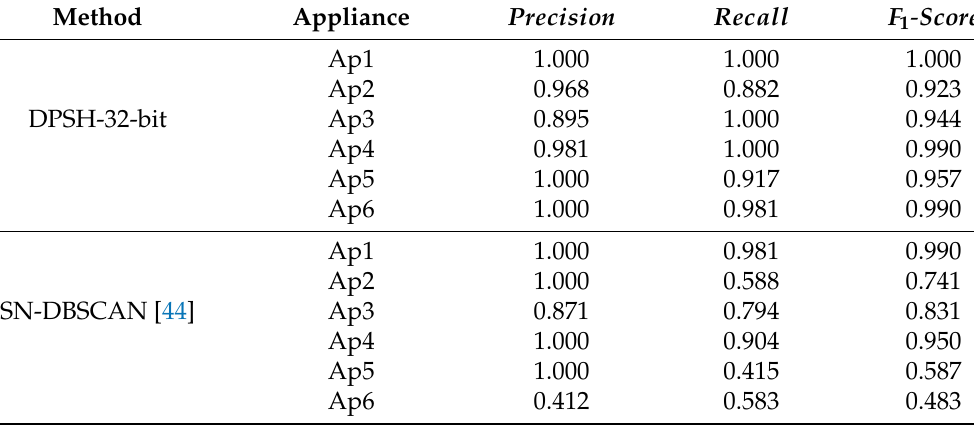
Table 8. The disaggregation performance of retraining on PLAID